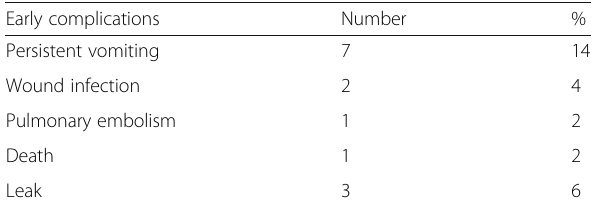
Table 2 Early complications in studied patients (during the first month post-operative)